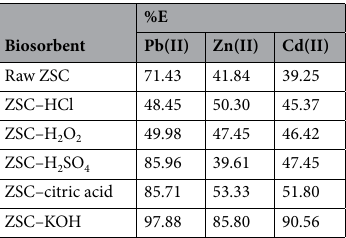
Table 1. The biosorption process for the Pb(II), Zn(II) and Cd(II) ions by raw and modified ZSCs at equilibrium